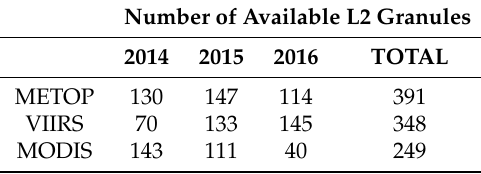
Table 2. Number of L2 granules available from 1 January 2014 to 31 December 2016 in the Madagascar case study